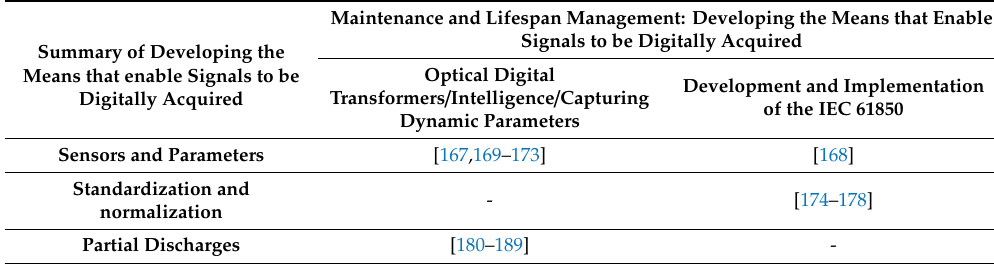
Table 7. Summary of Developing the Means that enable Signals to be Digitally